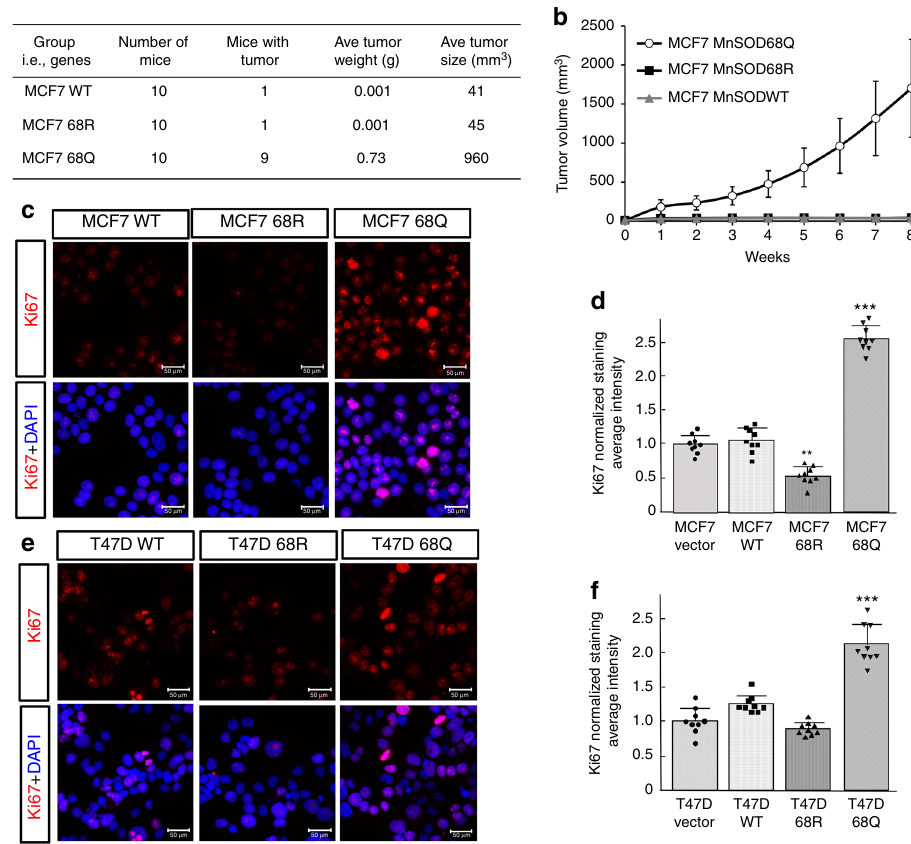
Fig. 2 MnSOD K68Q expression increases xenograft tumor growth and in vitro proliferation. a , b MCF7 cells expressing MnSOD WT , MnSOD K68R , and MnSOD K68Q were implanted into the hind limb of nude mice ( n = 10 per group) and tested for xenograft tumor growth. c , d MCF7 cells expressing MnSOD WT , MnSOD K68R , and MnSOD K68Q were c IF stained for Ki-67 and DAPI, and d quanti fi ed for Ki-67 intensity as determined by ImageJ analysis. e , f T47D cells expressing MnSOD WT , MnSOD K68R , and MnSOD K68Q were e IF stained for Ki-67 and DAPI, and f quanti fi ed for Ki-67 intensity. All experiments were done in triplicate. Error bars represent ±1 SEM. A one-way ANOVA analysis with Tukey ’ s post-analysis was used. ** p < 0.01 and *** p <